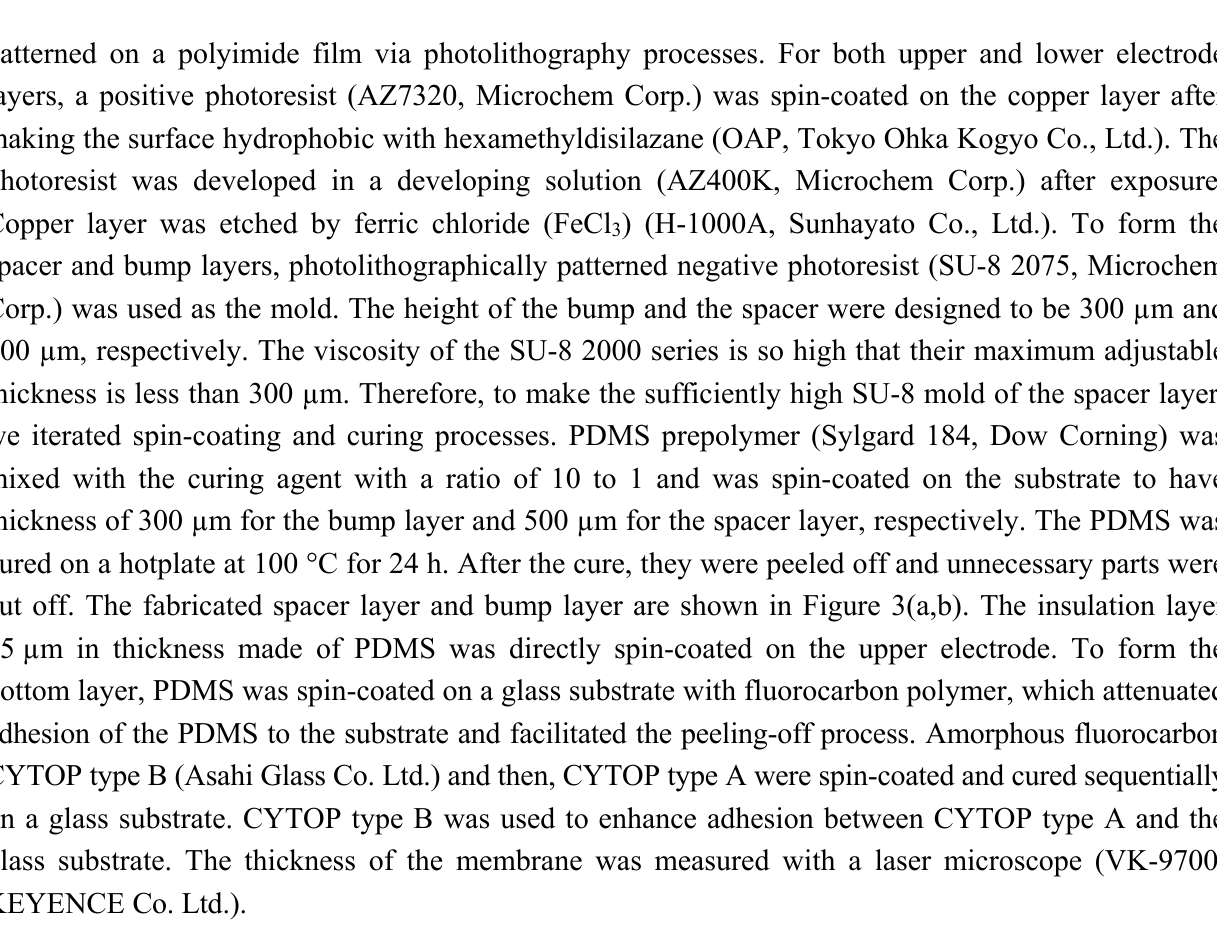
Figure 3. Photos of ( a ) the spacer layer (L4) and ( b ) the bump layer